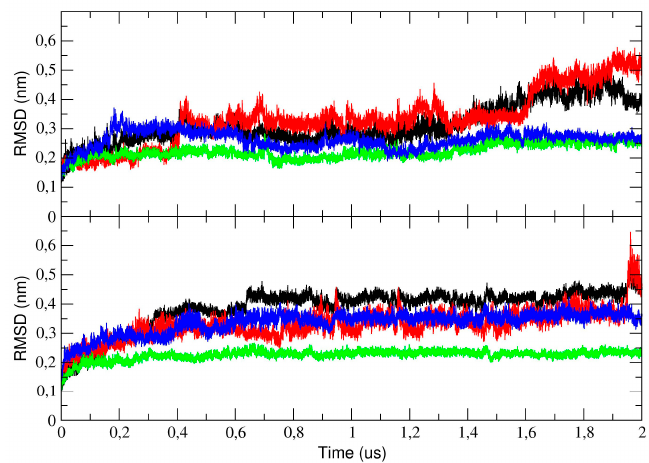
Figure 2. Root mean square deviation (RMSD) of the C α in the 2 µs molecular dynamics (MD) simulation for the monomer (upper graph) and the dimer (run #1, lower graph). The total RMSD is represented with a black line, while the RMSD of the domain I, II, and III is represented with a red, green, and blue line, respectively. The residue-based root mean square fluctuation (RMSF) in the trajectory was calculated to